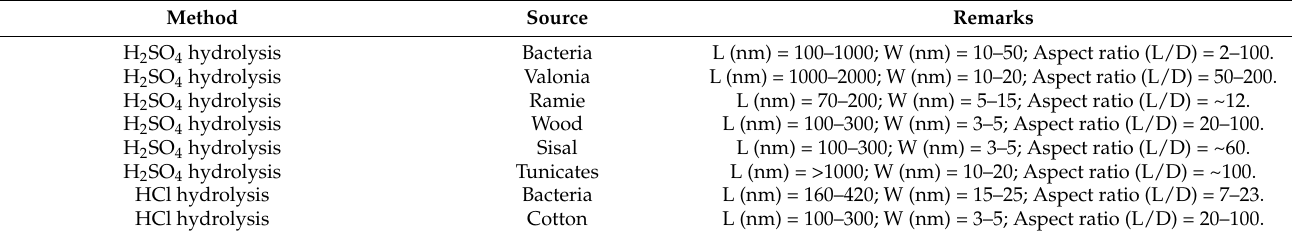
Table 1. Dimension of nanocellulose with respect to the various parameters. Reproduced with permission [7]. Copyright © 2018,